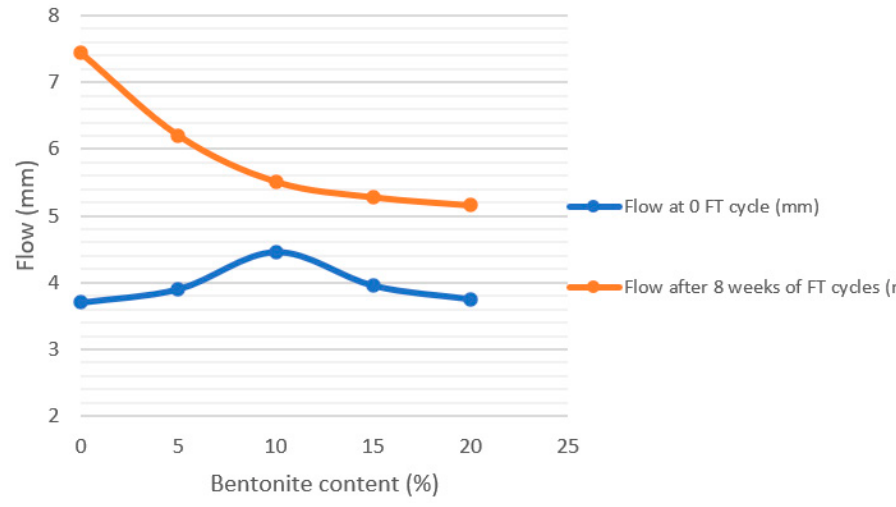
Figure 7. Flow with bentonite clay variation at different FT cycles.